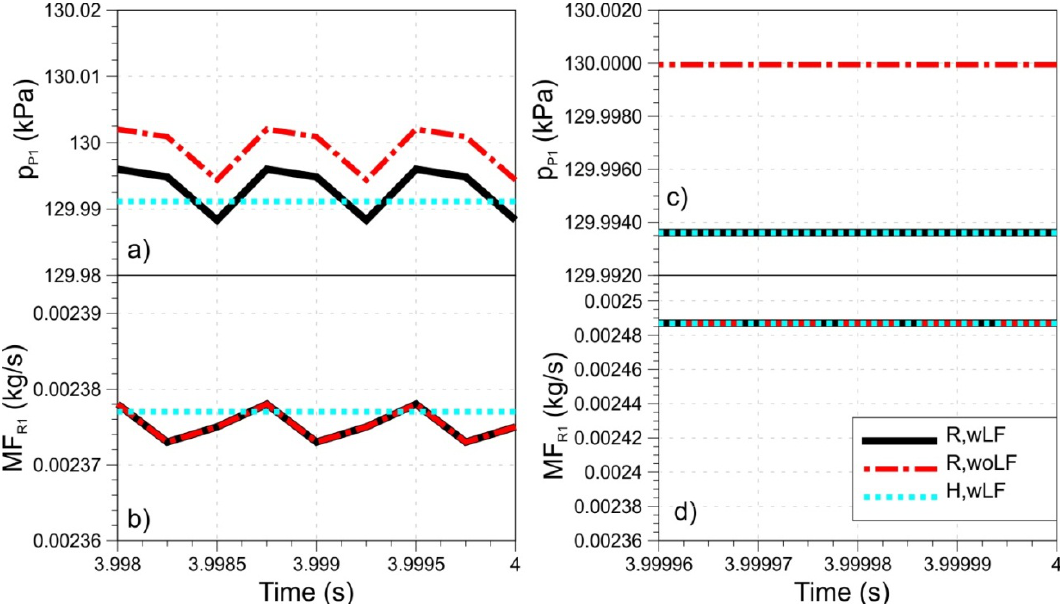
Figure 4. A1-R1-P1-R2-A2: pressure in P1 and mass flow through R1 for the time step 0.25 ms ( a and b ) and time step 0.005 ms ( c and d ). Results are calculated considering the TMB for Ralston (R) and Heun (H) scheme. Results with (wLF) and without (woLF) assumed laminar flow conditions for very small pressure ratios are